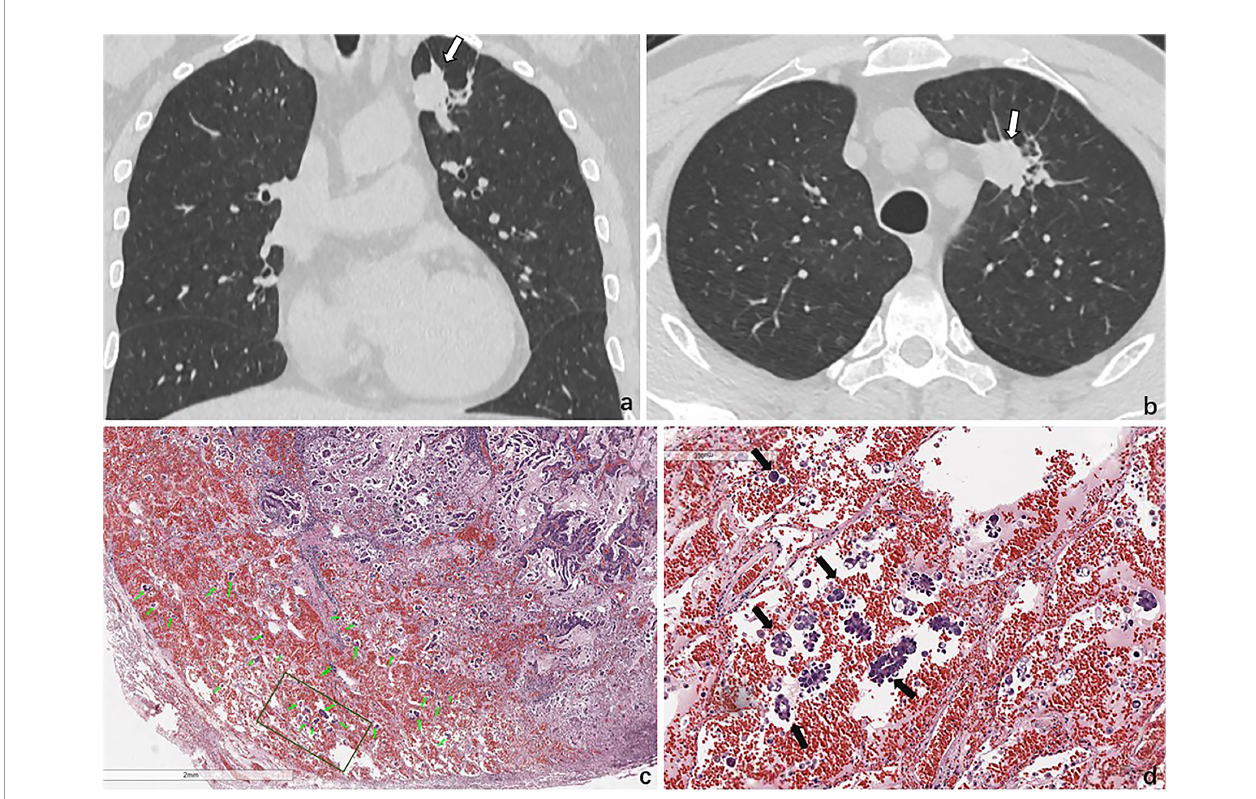
FIGURE 6 | STAS in a 47-year-old man with invasive adenocarcinoma. Baseline coronal (A) and axial (B) CT images show a solid nodule in the upper lobe of the left lung. (C) Photomicrograph shows multiple tumor cells spread though alveolar spaces (green arrows). (D) They are nestlike and distrusted in the alveolar cavity around the tumor (black